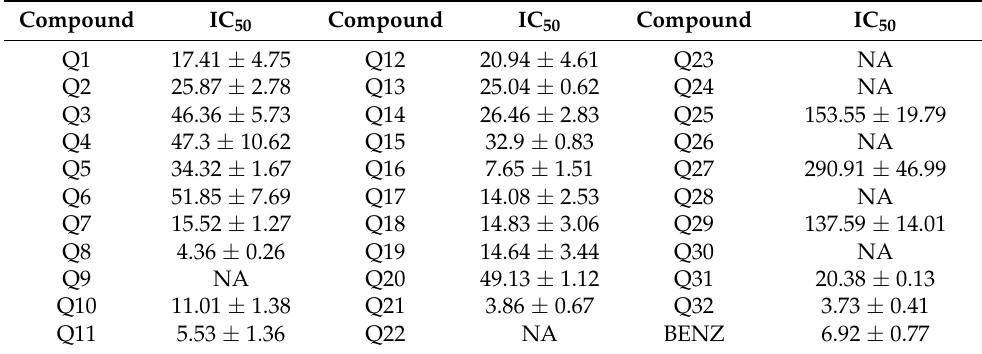
Table 1. Activity of the tested acrylonitriles against the epimastigote stage of T. cruzi in µ M (IC: inhibitory concentration). NA: not active.